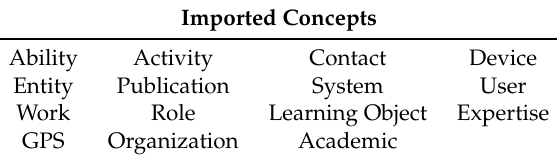
Table 4. Vocabulary imported from PiVOn ontology (limited to facilitate the